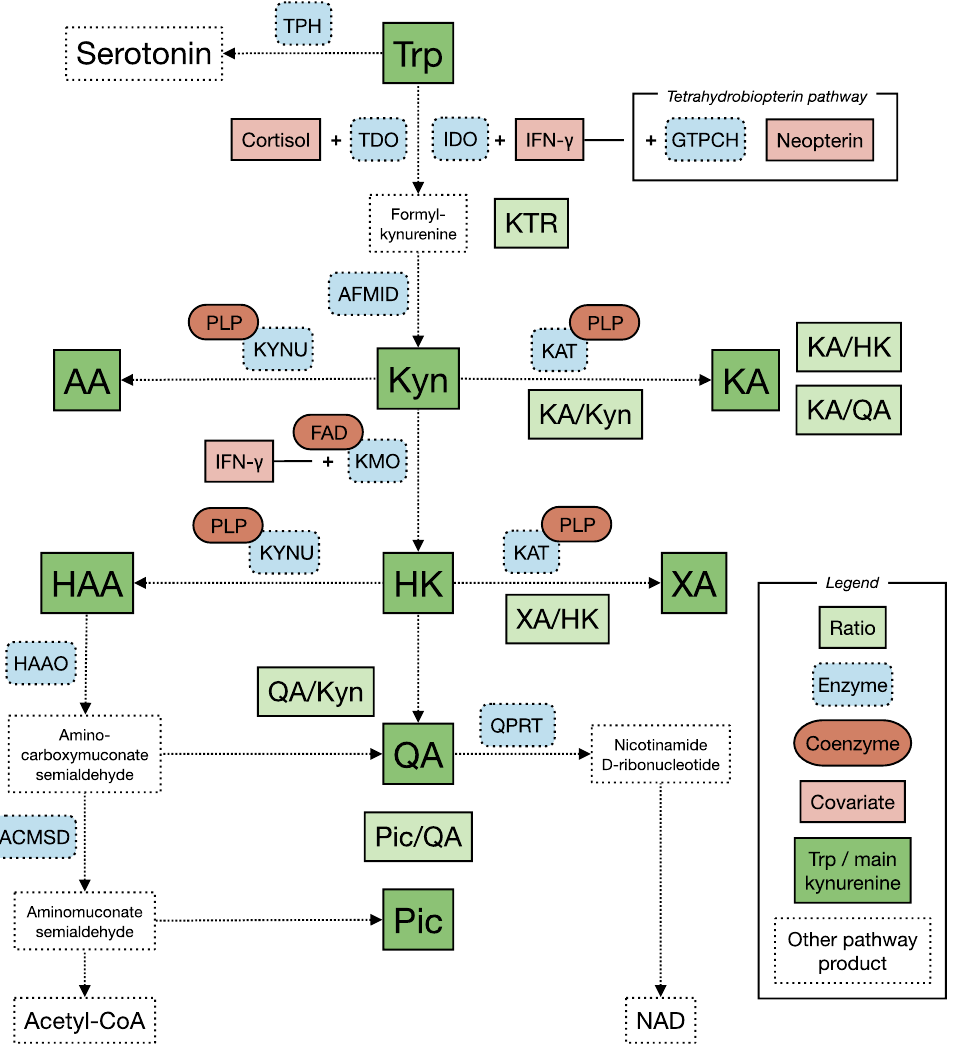
Figure 1. The kynurenine pathway of Trp metabolism. Abbreviations: Acetyl-CoA, acetyl coenzyme A; ACMSD, aminocarboxymuconate semialdehyde decarboxylase; AA, anthranilic acid; AFMID, arylformamidase; FAD, flavin adenine dinucleotide; CAA, competing amino acid; GTPCH, GTP cyclohydrolase; HAA, 3-hydroxyanthranilic acid; HAAO, 3-hydroxyanthranilate 3,4-dioxygenase; HK, 3-hydroxykynurenine; IDO, indoleamine 2,3-dioxygenase; KA, kynurenic acid; KAT, kynurenine aminotransferase; KMO, kynurenine monooxygenase; KTR, kynurenine-tryptophan ratio; Kyn, kynurenine; KYNU, kynureninase; LAT1, L-type amino acid transporter; NEFA, non-esterified fatty acid; NAD, nicotinamide adenine dinucleotide; Pic, picolinic acid; PLP, pyridoxal 5′ -phosphate;QA, quinolinic acid; QPRT, quinolinate phosphoribosyltransferase; TDO, tryptophan 2,3-dioxygenase; IFN- γ , interferon gamma; Trp, tryptophan; TPH, tryptophan hydroxylase; XA, xanthurenic acid. An alternative hypothesis suggests that alterations in concentrations of kynurenines themselves could play a role in depression [22–25]. Here, the most focus has been placed on the pathway’s neurotoxic potential and on three key pathway metabolites: